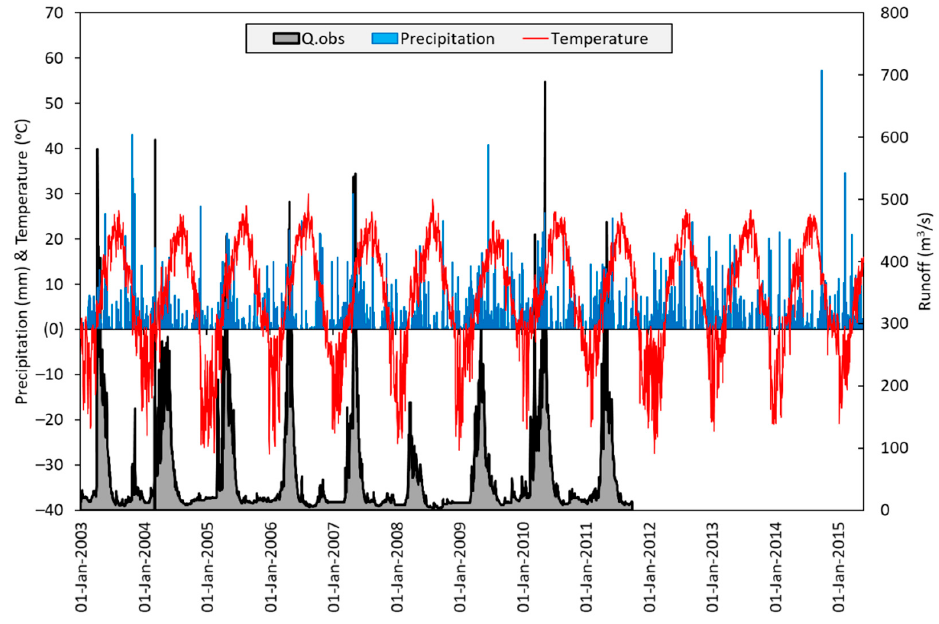
Figure 3. Daily precipitation and average air temperature records of Agri station and streamflow observation from Tutak stream gauge.